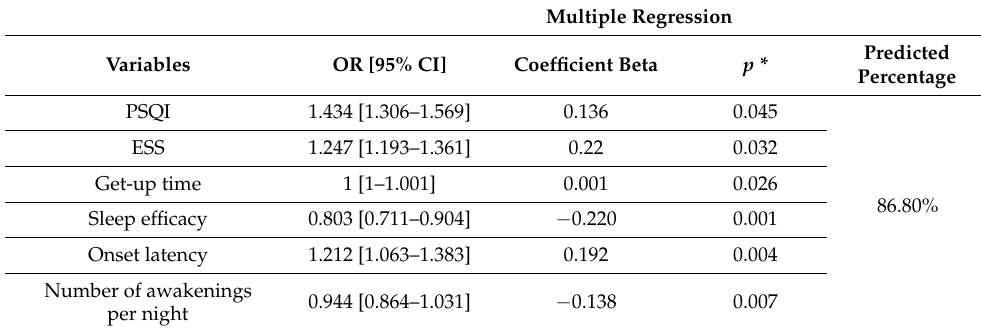
Table 6. Logistic regression analysis for sleep predictors of MHE.